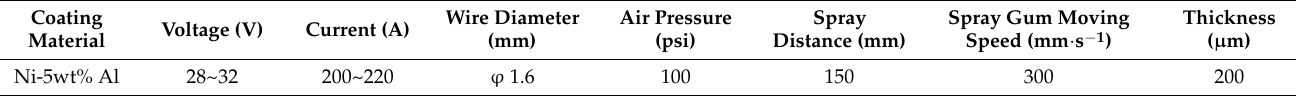
Table 2. Processing parameters of arc wire